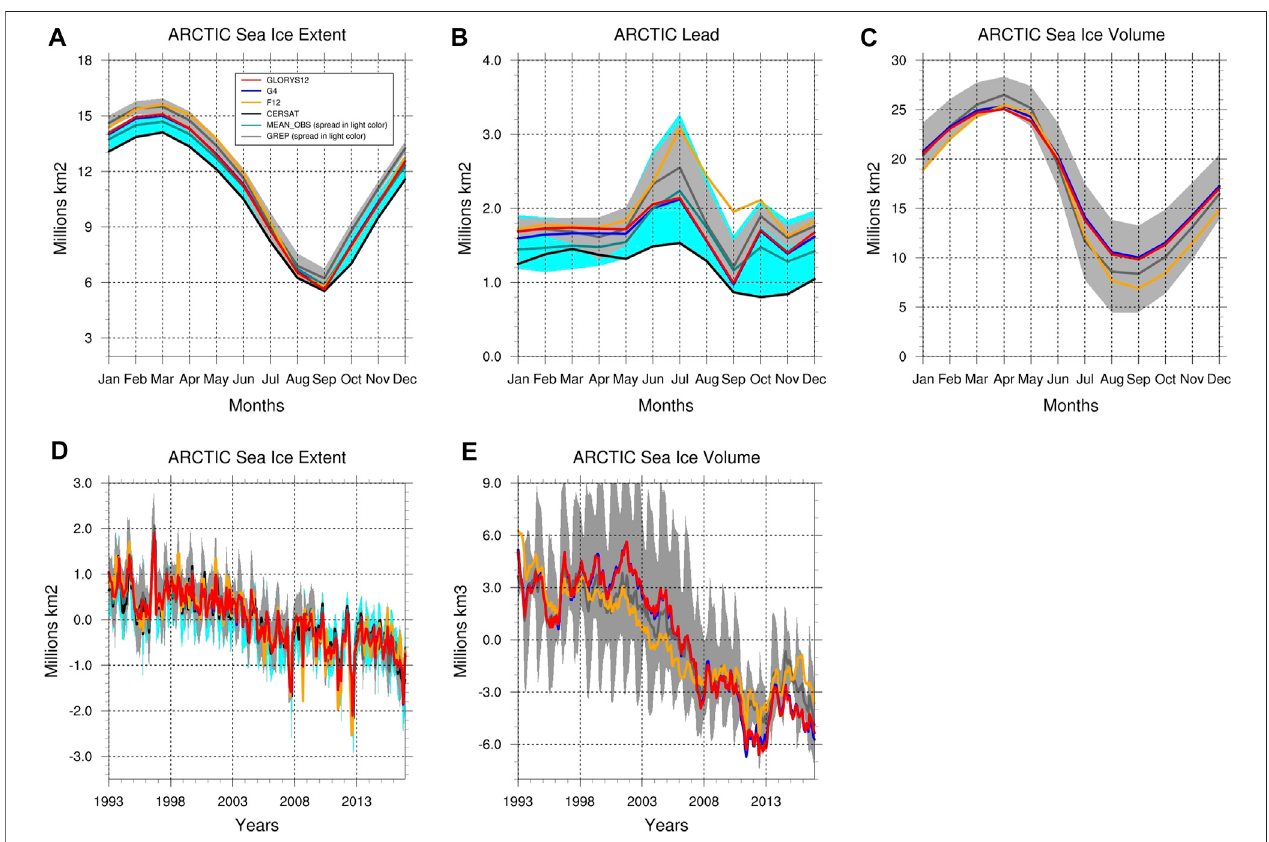
FIGURE 4 | Arctic Ocean – Mean seasonal cycle (1993 – 2016) of (A) Sea ice extent, (B) Sea ice leads, and (C) Volume. Interannual monthly variability of (D) Sea ice extentand (E) Seaicevolume. Units areinmillion km 2 forsea iceextent andleadsandinmillion km 3 forsea icevolume. GLORYS12 (red), F12(orange), G4(blue),GREP (dark grey with the spread in light grey), mean observations (dark cyan with the spread in cyan) among CERSAT (black), NOAA/NSIDC (not shown) and OSI-SAF (not shown).